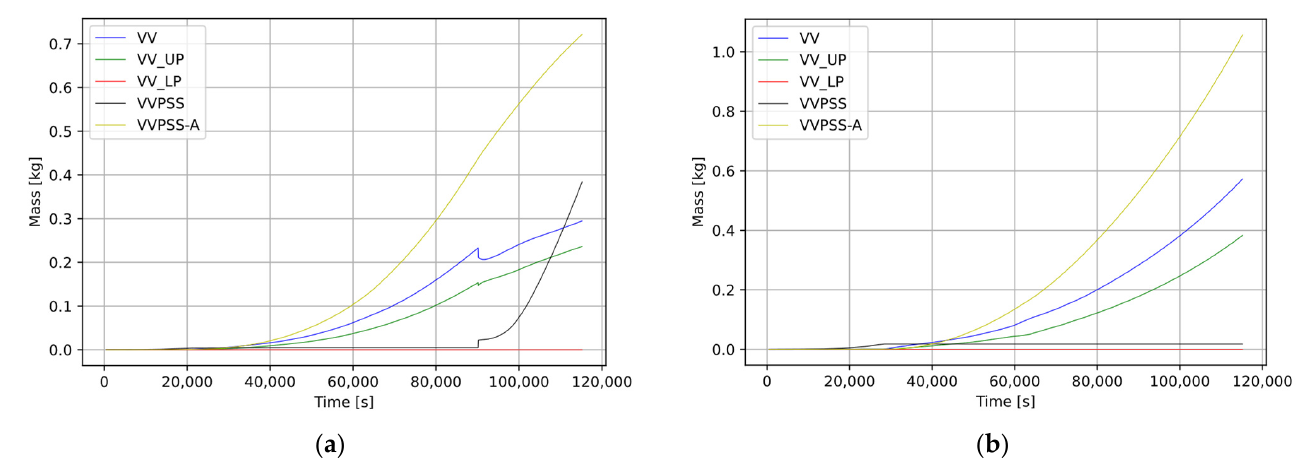
Figure 17. H2 inventory over time in selected CVs for PIE1 ( a ) and PIE2 ( b ) cases.